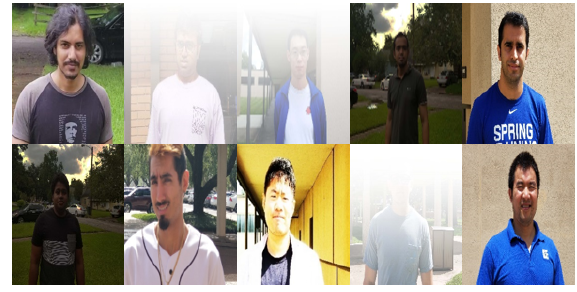
Figure 1. Image examples from LUDB